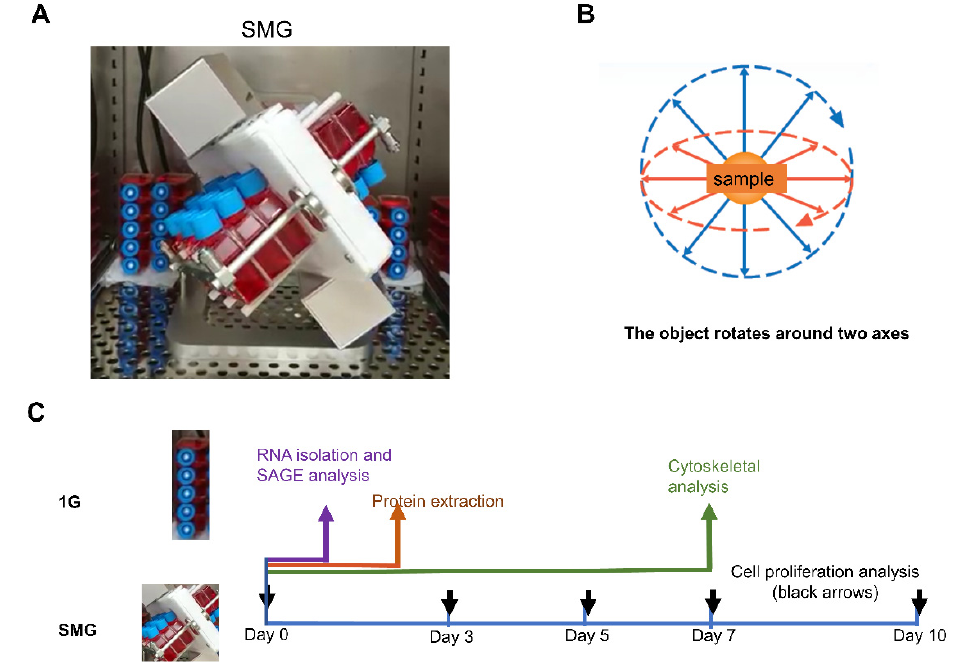
Figure 6. ( A ) By rotating the sample in three dimensions, gravity is evenly distributed, creating a simulated microgravity environment (https://prod.kiw.co.jp/medical/zeromo.html) (accessed on 23 December 2020). The gravity of all flasks was less than 10 − 3 G. ( B ) Schematic diagram of the clinostat. ( C ) A schematic representation of the experimental design. Black arrows indicate the day for cell proliferation analysis, a brown arrow indicates the day for protein extraction, a blue arrow indicates the day for RNA sampling, and a green arrow indicates the day for cytoskeletal analysis.